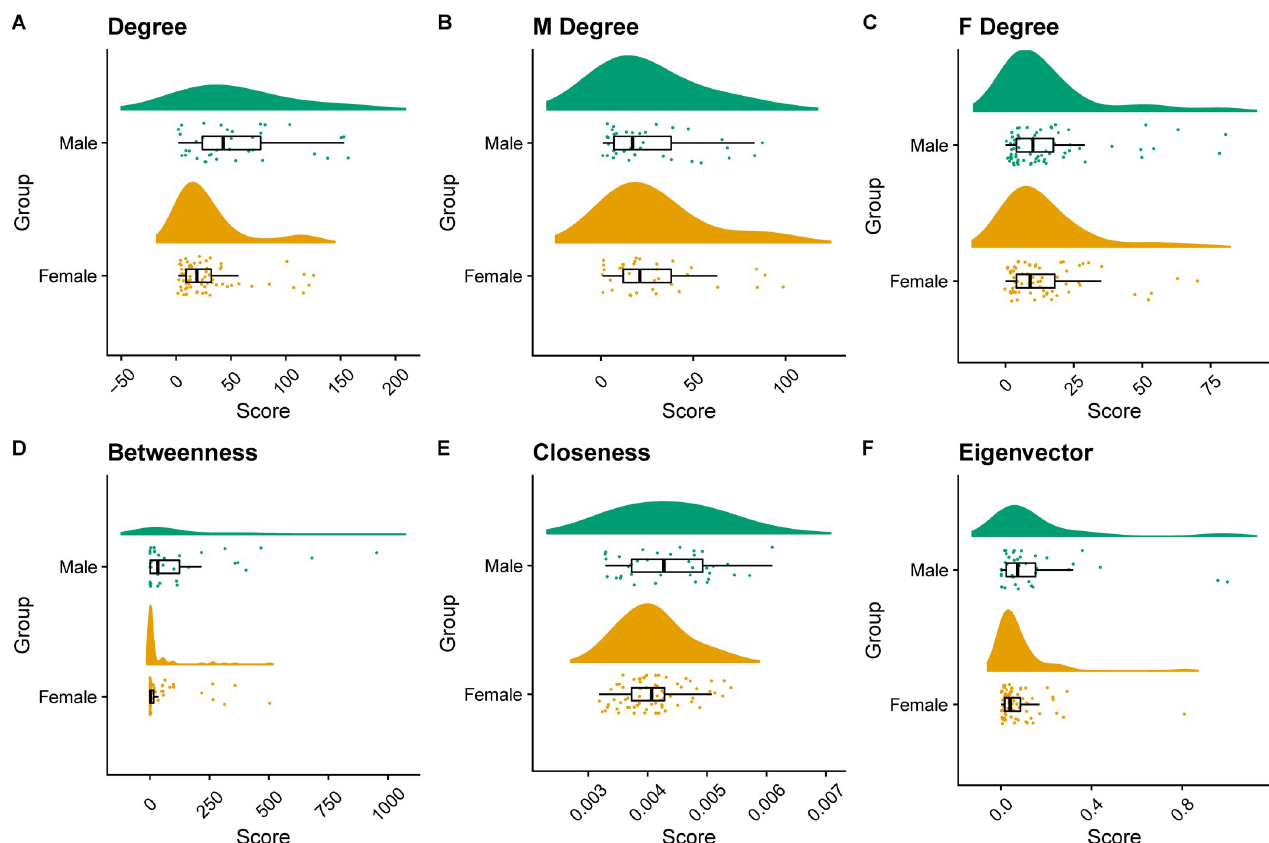
Fig 7. Raincloud plots for the male/female group centralities. The raincloud plots with boxplots for the scores of the computed centralities for the female and male author groups in the CING co-authorship network including the average (1) degree for all (2) degree for male authors (M Degree) to male/female authors, (3) degree for female authors (F Degree) to male/female authors, (4) betweenness, (5) closeness and (6) eigenvector